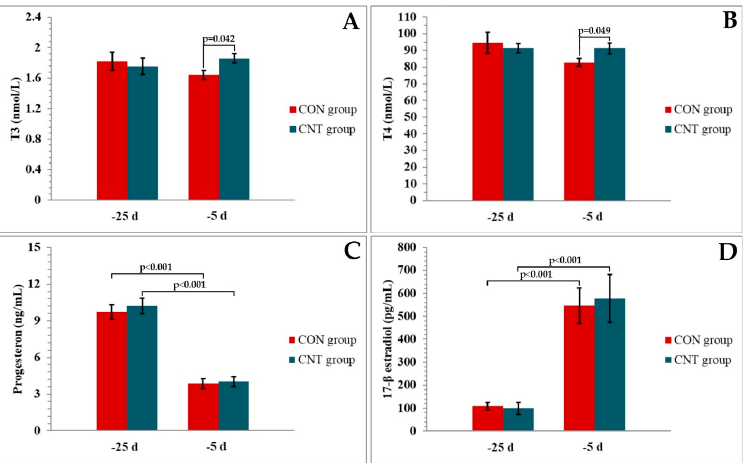
Figure 1. Concentrations of ( A ) triiodothyronine (T 3 ), ( B ) thyroxine (T 4 ), ( C ) progesterone, and ( D ) 17- β estradiol in serum of CON and CNT groups of cows at 25 and 5 days before expected parturi- tion. Values are expressed as mean ± SE. ( A ) Effects of treatment ( p = 0.332), time ( p = 0.754), and interaction between treatment and time ( p = 0.050); ( B ) effects of treatment ( p = 0.532), time ( p = 0.151), and interaction between treatment and time ( p = 0.050); ( C ) effects of treatment ( p = 0.742), time ( p < 0.001) and interaction between treatment and time ( p = 0.753); ( D ) effects of treatment ( p = 0.540), time ( p < 0.001), and interaction between treatment and time ( p = 0.531). Significant differ- ences between groups as well as differences along the time points within each group are indicated by p values (Fisher post hoc test). − 25 d = first day of chestnut tannins supplementation (25 ± 2 days before parturition). − 5 d = 5 days before parturition.